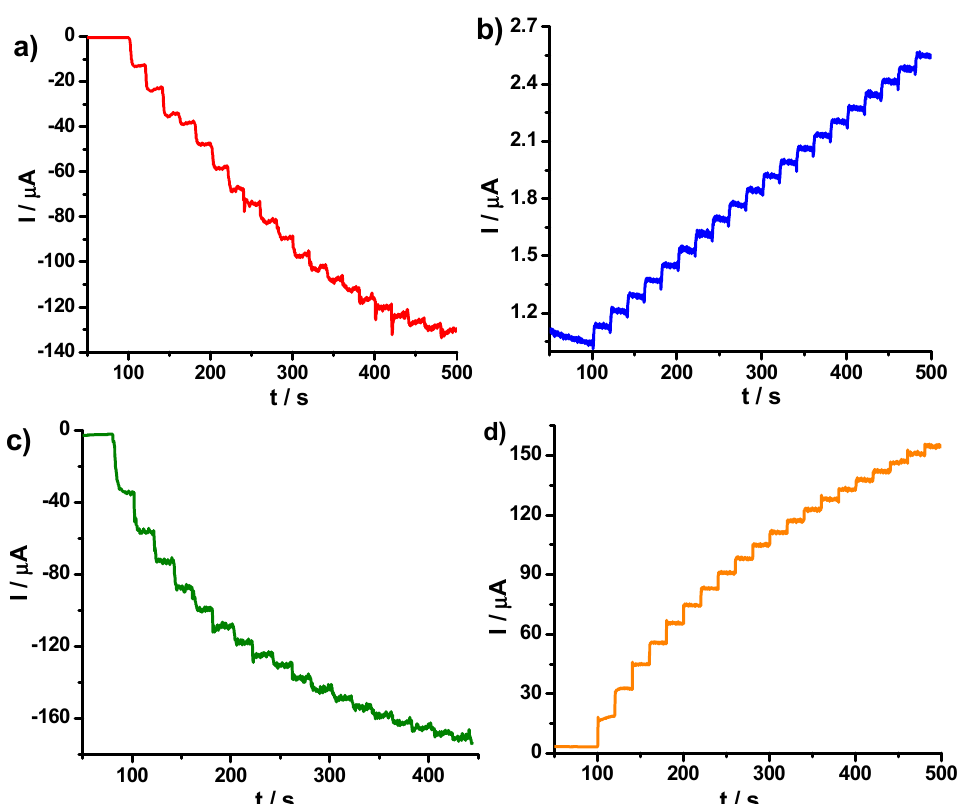
Figure 9. Chronoamperometric detection of H 2 O 2 at the PB–TiO 2 / fCNT / GC electrode: ( a ) PB reduction zone and ( b ) PB oxidation zone. Chronoamperometric detection of H 2 O 2 at the PB–fCNT / GC electrode: ( c ) PB reduction zone and ( d ) PB oxidation zone.